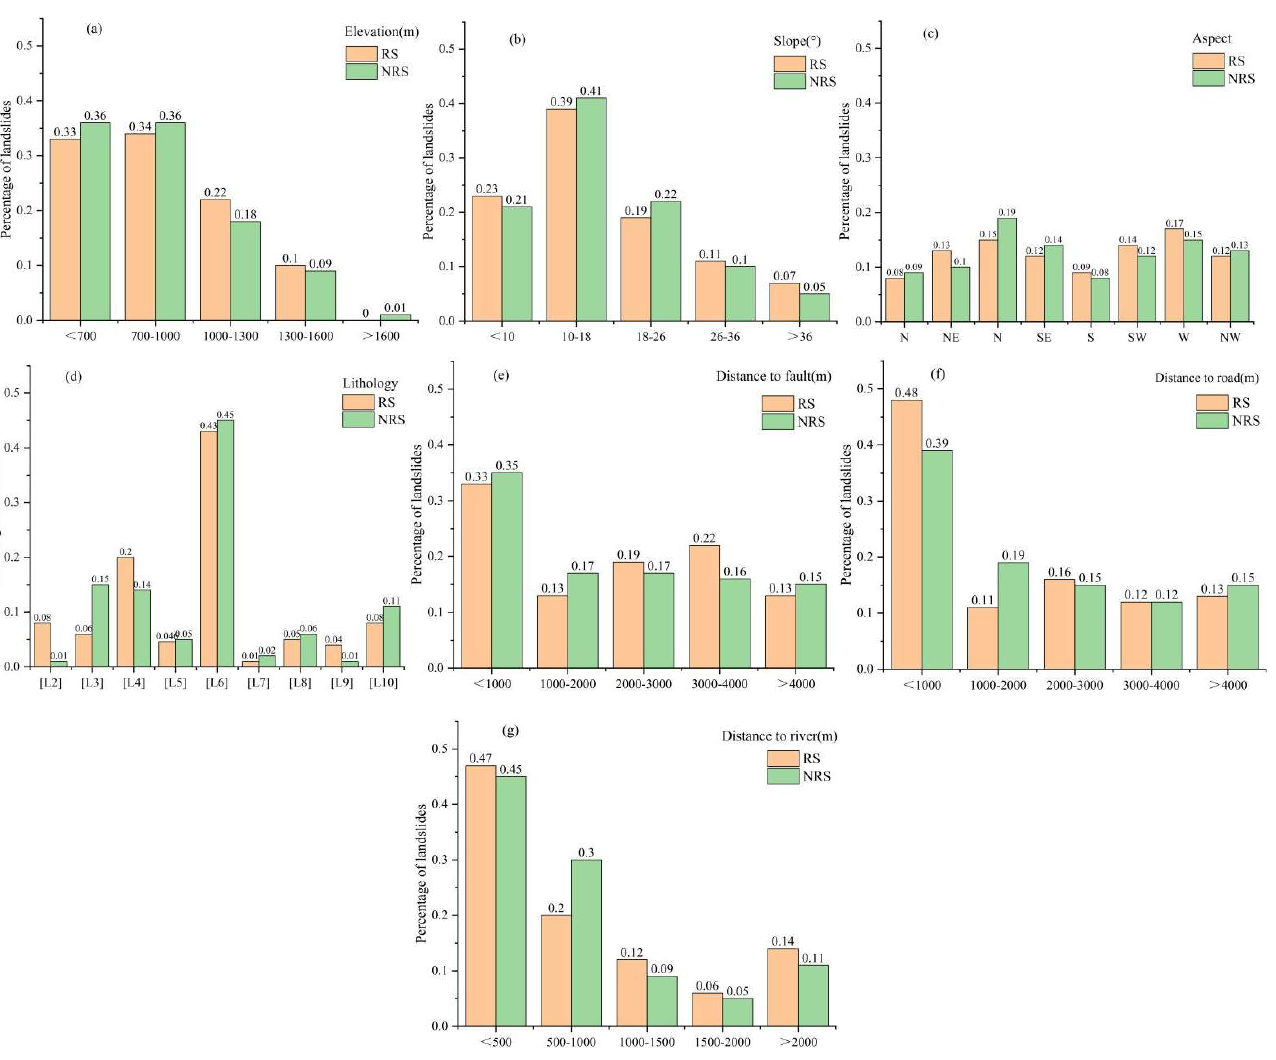
Figure 6. Data of assessment indicators in RS and NRS: ( a ) elevation; ( b ) slope; ( c ) aspect; ( d ) li- thology; ( e ) distance to fault; ( f ) distance to road; ( g ) distance to river. ( e ) distance to fault; ( f ) distance to road; ( g ) distance to